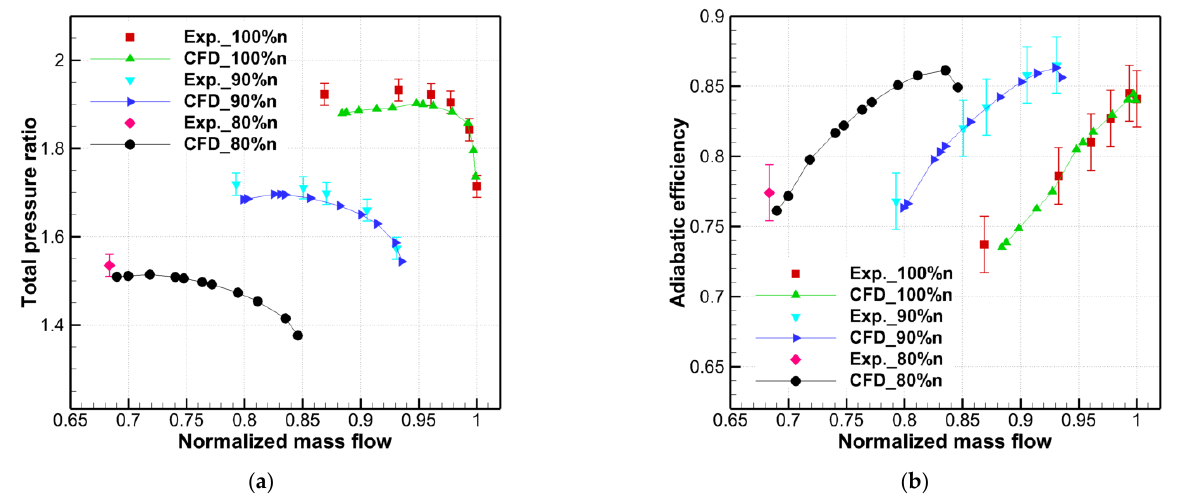
Figure 4. Comparison of compressor aerodynamic performance between numerical and experimental results: ( a ) Total pressure ratio ; ( b ) Adiabatic efficiency .